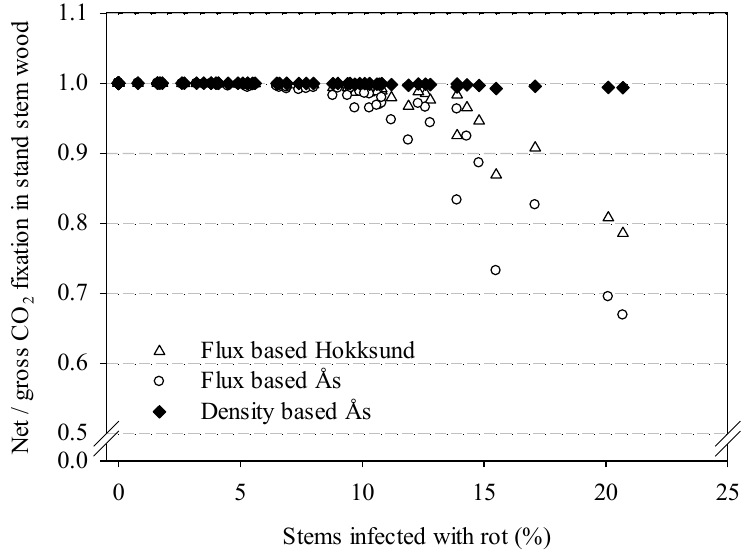
Figure 7. Ratio of net-to-gross CO 2 fixation per hectare in the stem wood at Heterobasidion infested Norway spruce stands, as estimated from CO 2 fluxes and rot prevalence in tree stems; see text for explanation of the method. The flux based estimates are from the five Heterobasidion infected trees monitored at Hokksund and the one monitored at Ås. Wood density estimates are based on stem section data of one Norway spruce tree that showed an extensive stem decay column caused by Heterobasidion parviporum in our previous study [26] (tree